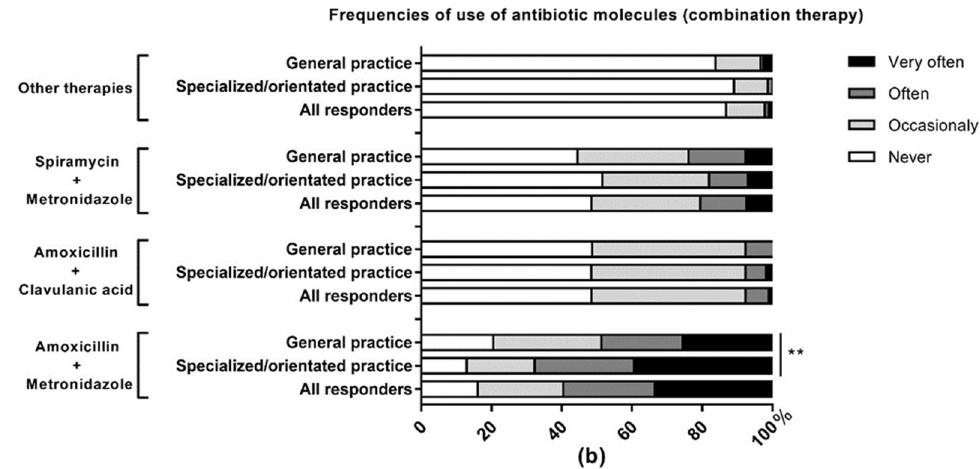
Figure 2. Use of antibiotic molecules in periodontal therapy . ( a ) Antibiotic molecules most frequently prescribed as monotherapy; ( b ) antibiotic molecules most frequently prescribed as combination therapy. The data are presented as percentage and according to the affiliation of the respondents. Specialized/orientated practice means that the dentist is affiliated to the SFPIO (French society of periodontology and oral implantology) and/or the CNEP (French college of University teachers in periodontology); general dental practice means that the practitioner did not declare membership in the SFPIO or CNEP. This include members of ReCOL (French general dental practice-based research network) and practitioners with no affiliation disclosed; ** p < 0.01.